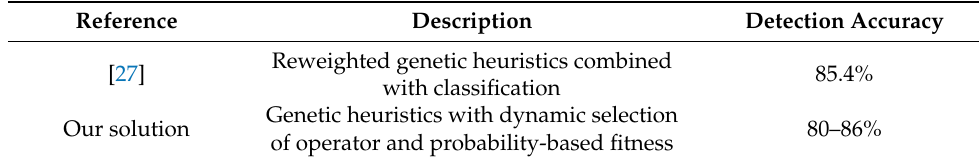
Table 3. Routine detection comparative results.